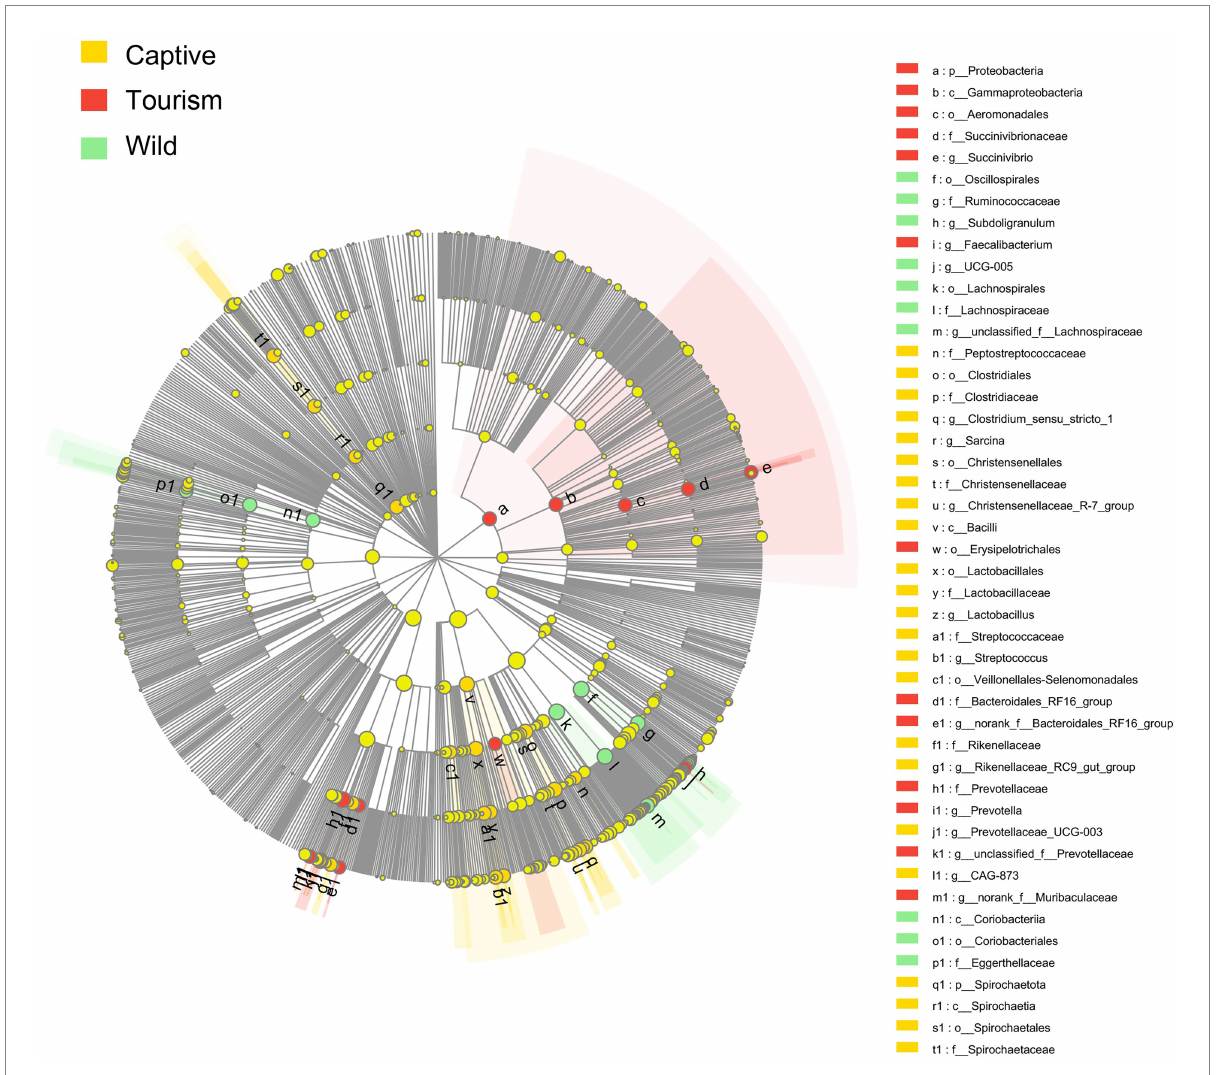
FIGURE 5 Indicators of known taxa in one of the three groups. At the genus, family, order, class, and phylum levels. Indicators identified by linear discriminant analysis effect size (LEfSe) analysis (LDA > 3, p <